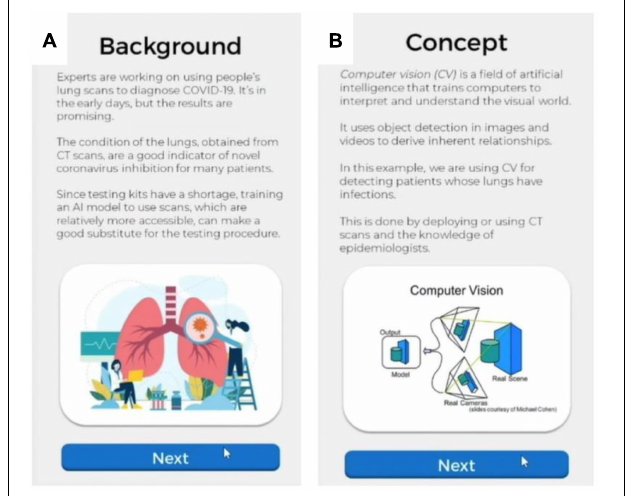
FIGURE 2 | Artificial intelligence showing narrative (A) and concept introduction (B)